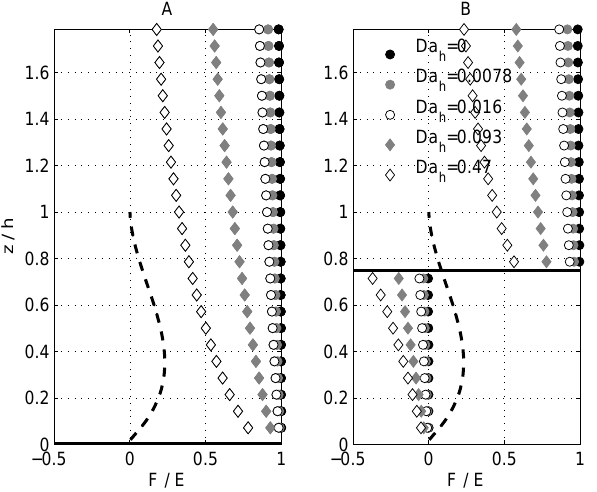
Fig. 5. Effect of stability on the flux-to-surface-exchange ( F / E ) ra- tio at the height where measurement height ( z ) ratio to the canopy height ( h ) is 1.5. On x-axis is the inverse of the Obukhov length ( L ) normalized with canopy height ( h ) and on y-axis is the canopy- top Damk¨ohler number. The numbers on curves refer to flux-to- emission